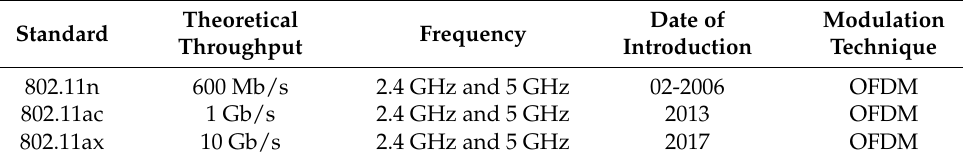
Table 1. List of selected standards of the 802.11 transmission.